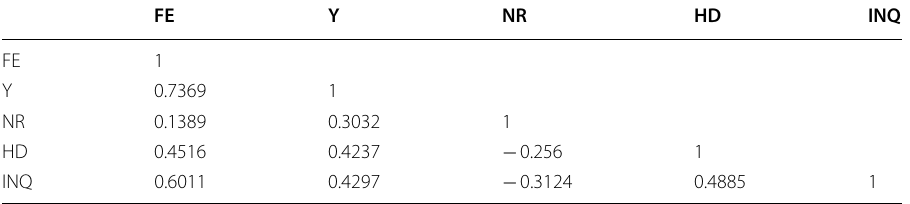
Table 5 Correlation matrix for the panel